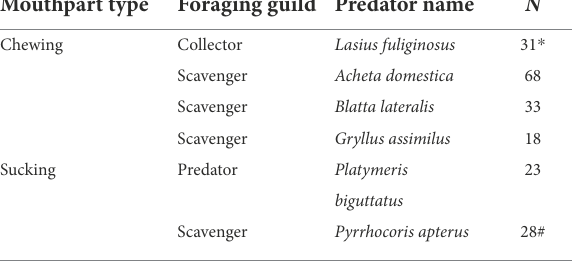
TABLE 2 Predators used and their characteristics.